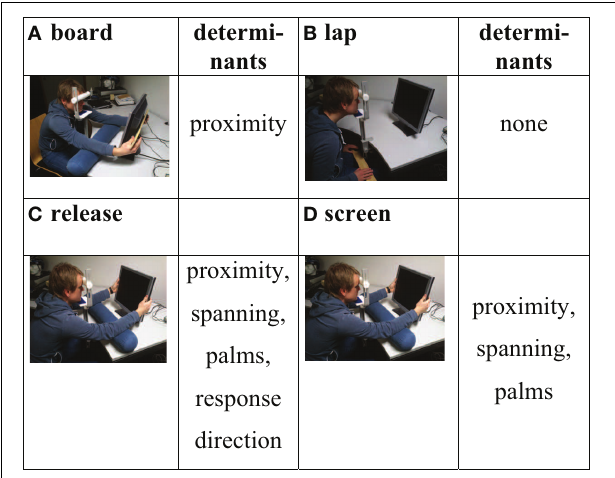
FIGURE 3 | Hand postures used in the Experiments 2–4, labels for the hand postures, and determinants instantiated by the posture: (A) board posture, (B) lap posture, (C) release posture, and (D) screen